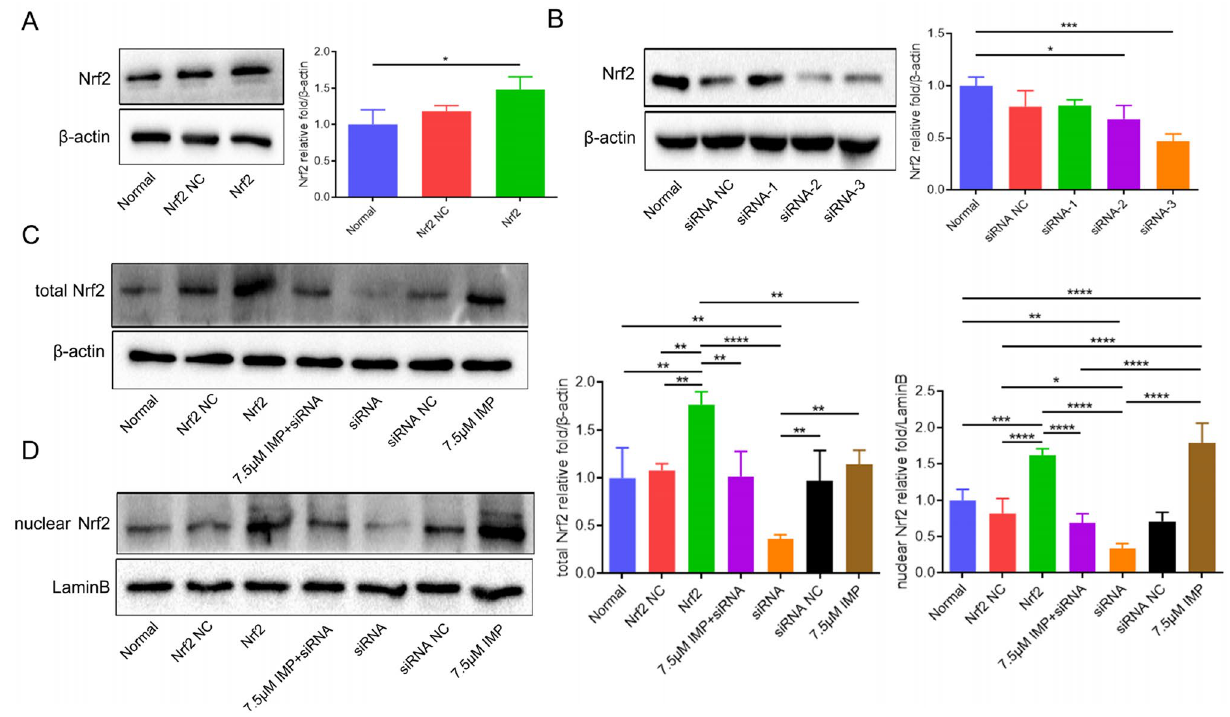
Figure 9. IMP exerts a protective effect on the VD cell model prepared by CoCl2-induced hypoxic hippocampal neuronal cells by regulating the Nrf2 signaling pathway. ( A ): the relative expression of Nrf2 after transfection of the overexpression vector. ( B ): the relative expression of Nrf2 after siRNA-1, siRNA-2, siRNA-3 transfection. ( C ): relative expression of total Nrf2 in VD cell model by different treatments. ( D ): relative expression of nuclear Nrf2 in VD cell model with different treatments. Dividing lines were used to make explicit for the grouping of blots cropped from diferent parts of the same gel or from diferent gels. The experiment was repeated three times, and the data was shown as mean ± standard deviation. (n = 3 for every group, * P < 0.05, ** P < 0.01, *** P < 0.001, **** P < 0.0001 by one-way